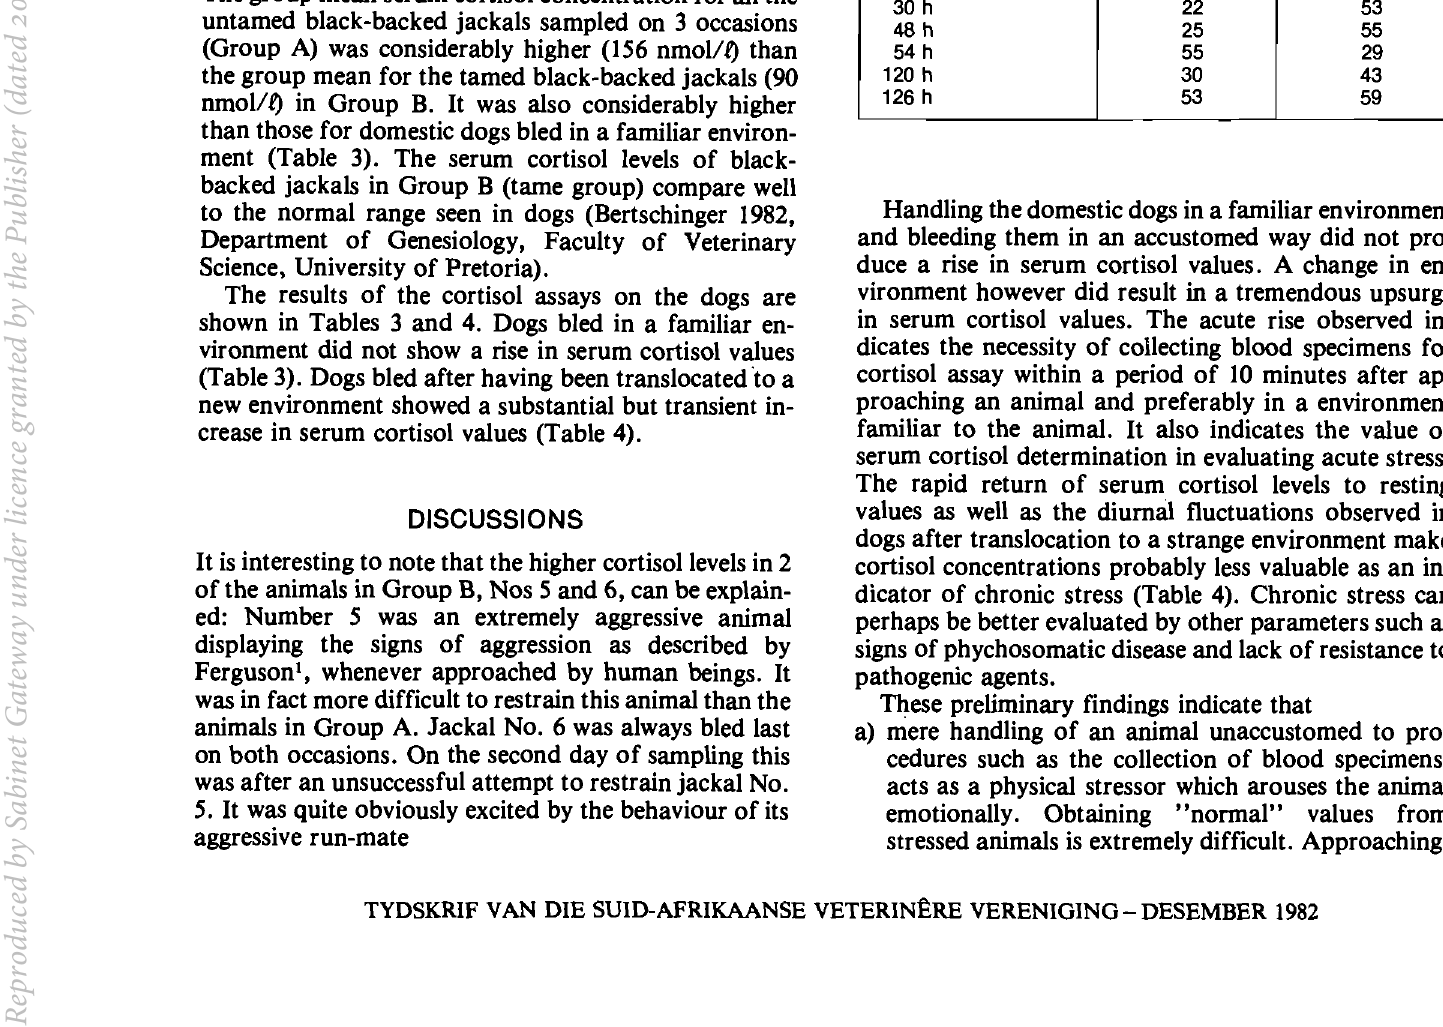
Table 2: GROUP B. SERUM COFITISOL LEVELS IN TAMED BLACK·BACKED JACKALS